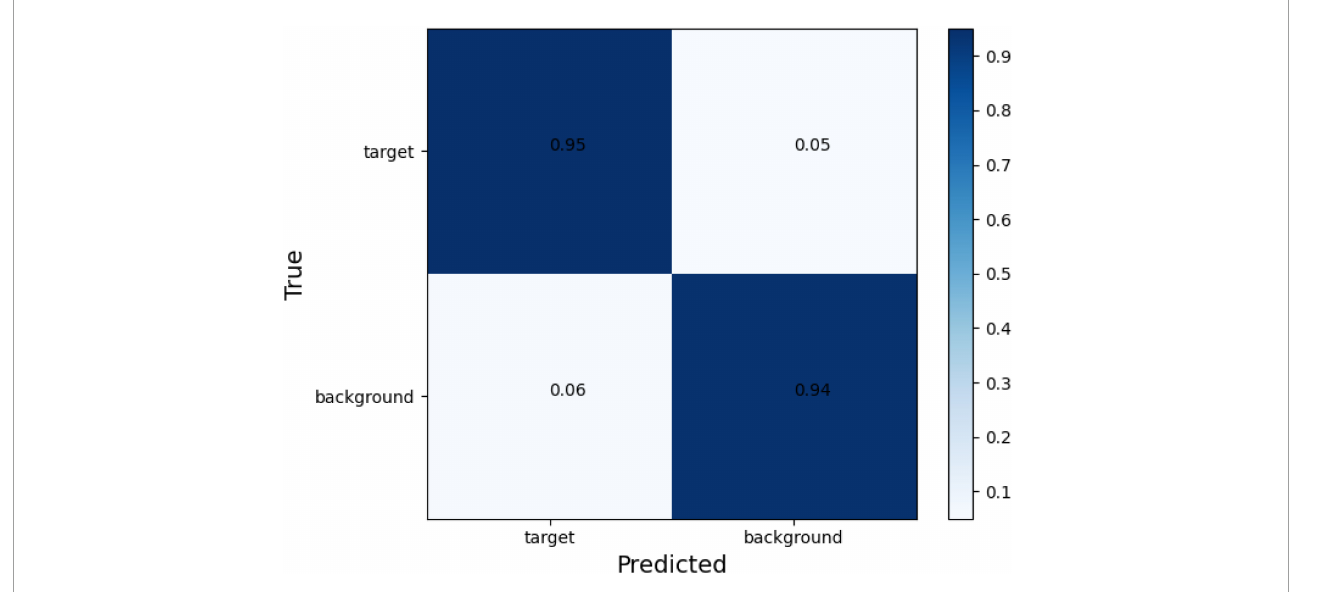
FIGURE7 Confusion matrix of CCPR